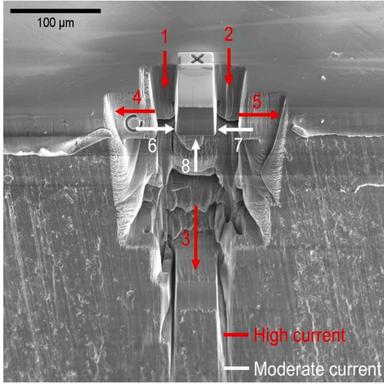
A complete pillar ready for 3D EBSD with fiducials on the top and front surfaces and numbered arrows indicating the most efficient sequence of cuts to prevent redeposition on the pillar.